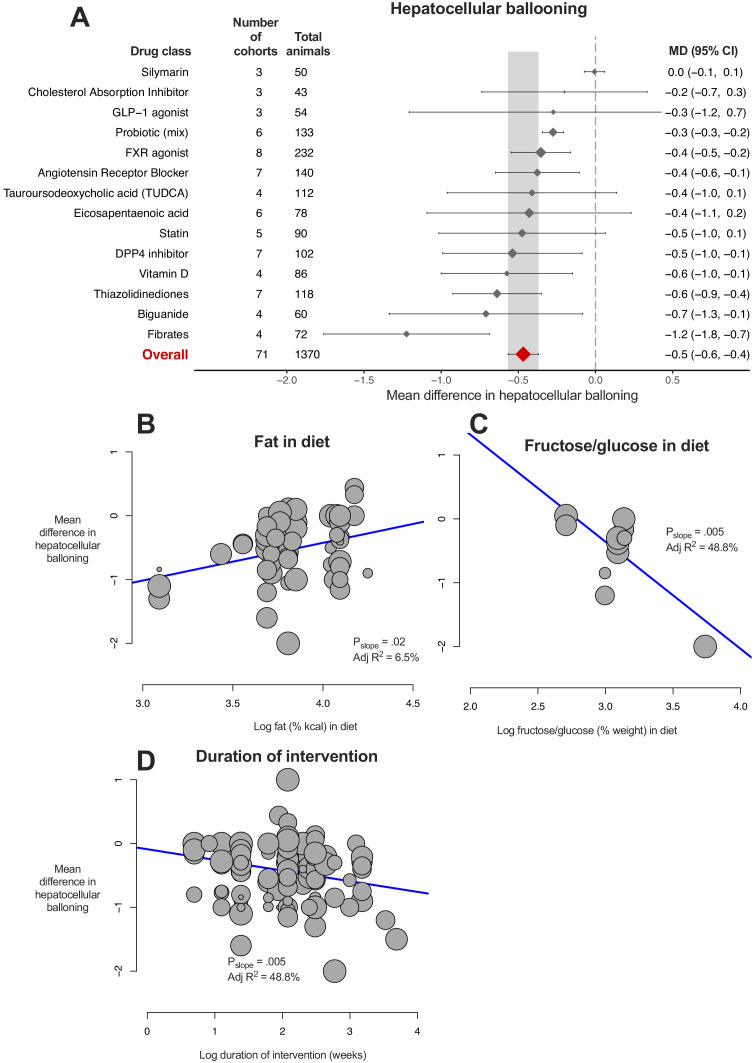
Meta-analysis of hepatocellular ballooning in rodent studies of NAFLD.(A) Forest plot with subgrouping by class of drug. Individual studies have been hidden and only subgroup summaries are illustrated. The total number of animals is calculated from the sum of control and interventional animals for each subgroup. CI, confidence interval; DPP4, Dipeptidyl peptidase-4; FXR, Farnesoid X receptor; GLP-1, Glucagon-like peptide-1; MD, mean difference; TUDCA, tauroursodeoxycholic acid. (B) Meta-regression bubble plot using (log) fat (%kcal) in diet for each cohort. (C) Meta-regression bubble plot using (log) fructose/glucose (% weight) in diet for each cohort. (D) Meta-regression bubble plot using (log) duration of intervention (in weeks) for each cohort.Figure 6—source data 1.Results of meta-analysis and meta-regression of hepatocellular ballooning in rodent studies of NAFLD.Tab 1. Results from meta-analysis of hepatocellular ballooning with subgroup by drug class. Tab 2. Results from meta-analysis of hepatocellular ballooning with subgroup by individual drug. Tab 3. Results from meta-analysis of hepatocellular ballooning with subgroup by drug class, after removal of outlier studies. Tab 4. Results from univariable meta-regression analyses.